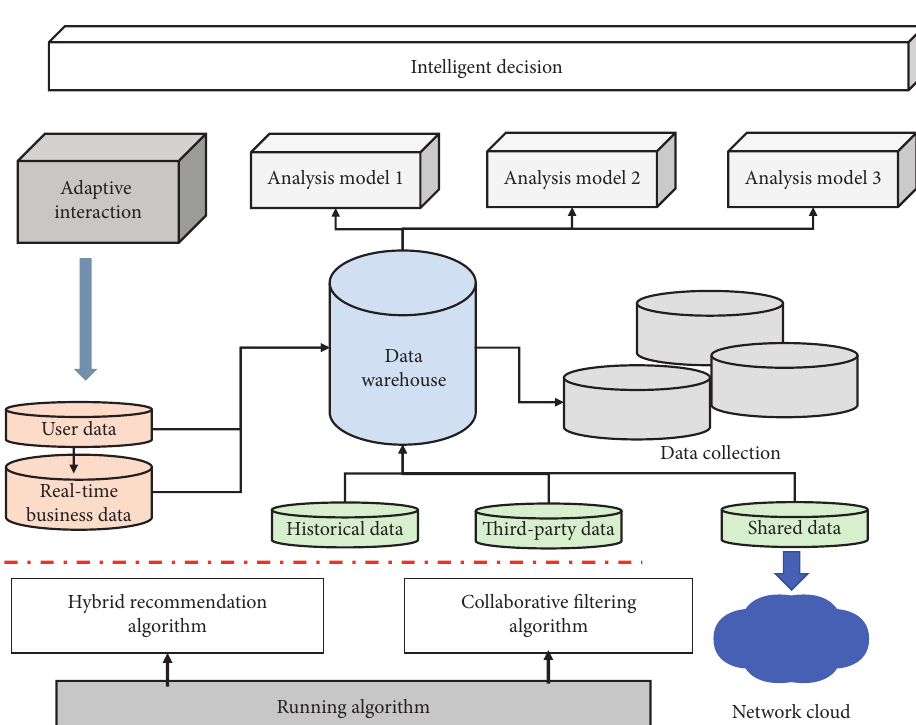
Figure 4: Schematic representation of the business logic of the modeling and forecasting tool.